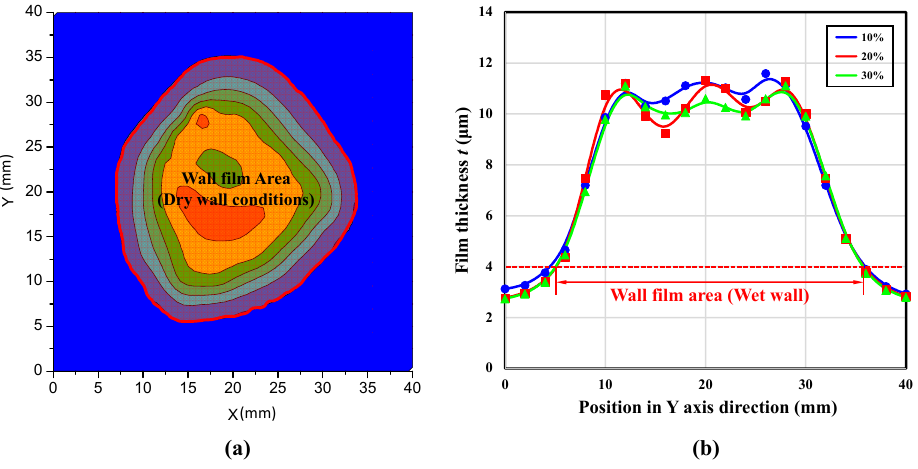
Figure 6. Definition of the wall film area for: ( a ) dry wall conditions; and ( b ) wet wall conditions.